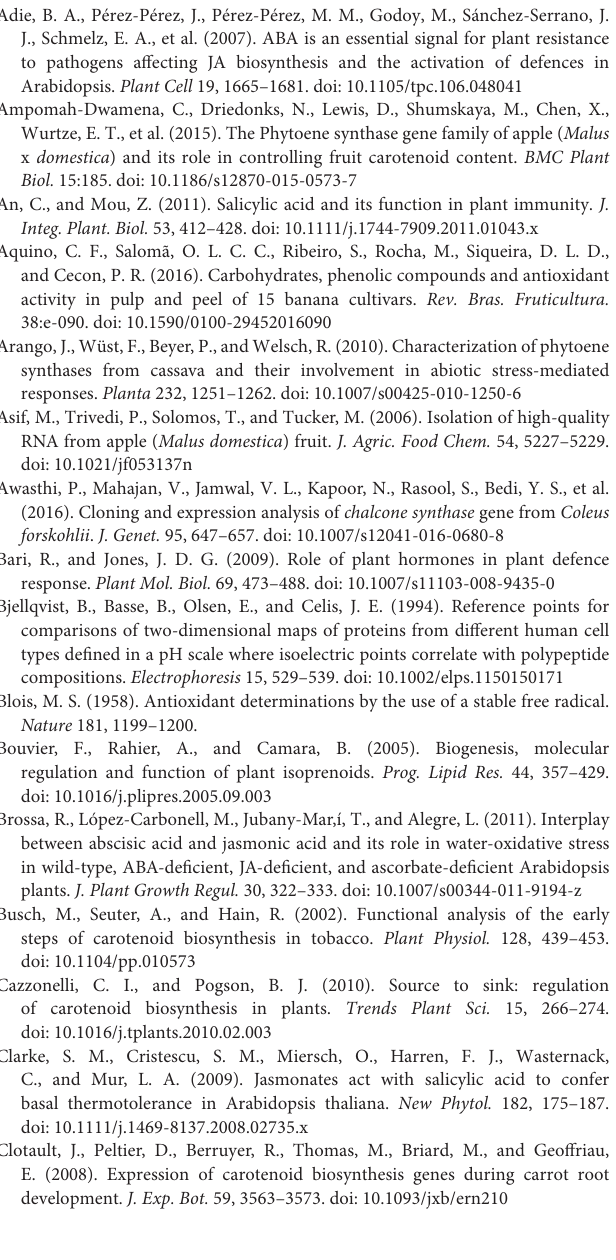
Supplementary Figure S3 | Representative HPLC profiles illustrating the accumulation of carotenoids in fruit-peel of banana. Peaks in chromatograms are representing 1: lutein, 2: zeaxanthin, 3: α -carotene, 4: β -carotene and 5: lycopene. Extract was separated with HPLC coupled with UV and PDA detector. Supplementary Figure S4 | Analysis of PSY protein sequences. Multiple sequence alignment of putative protein sequences of PSY1 of Rasthali and Nendran along with different monocots PSY sequences. The GenBank accession numbers for different PSY sequences were given in the Supplementary Table S6 . Supplementary Table S1 | List of the primers used in the present study.